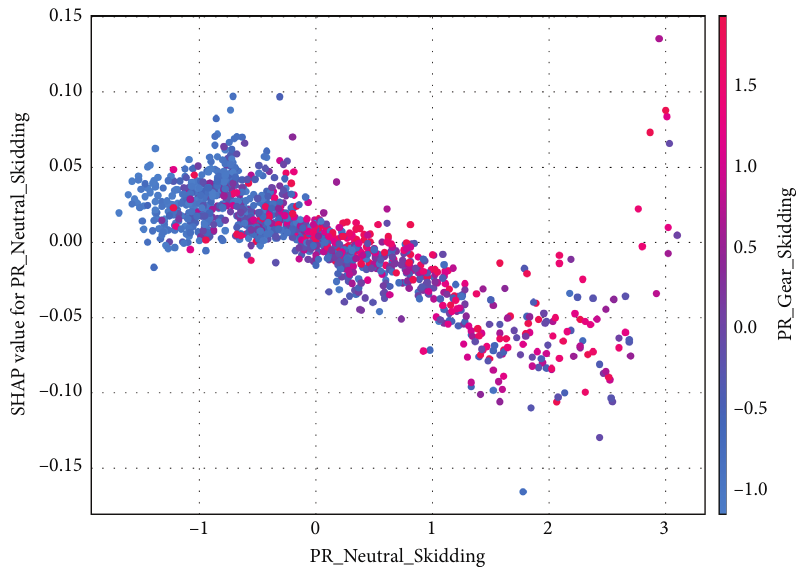
Figure 10: The global impact of rolling without engine load on fuel consumption.